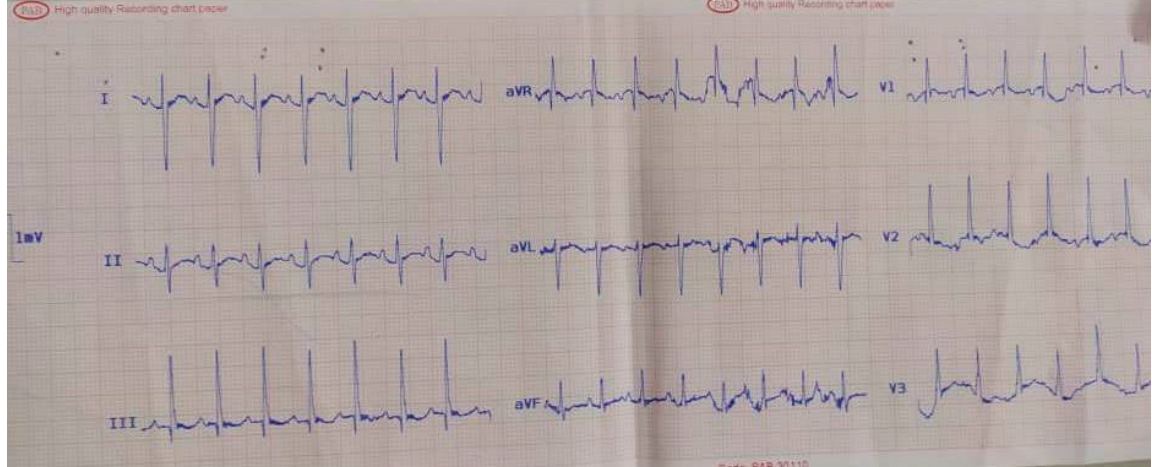
Pediatr. Rep. 2021 , 13, FOR PEER REVIEW 2 A 9-year-old boy presented to the emergency department with palpitations in daily activities, and without any other complications and no past medical history detected. He had such episodes before and was treated by beta blockers (propranolol) without any re-